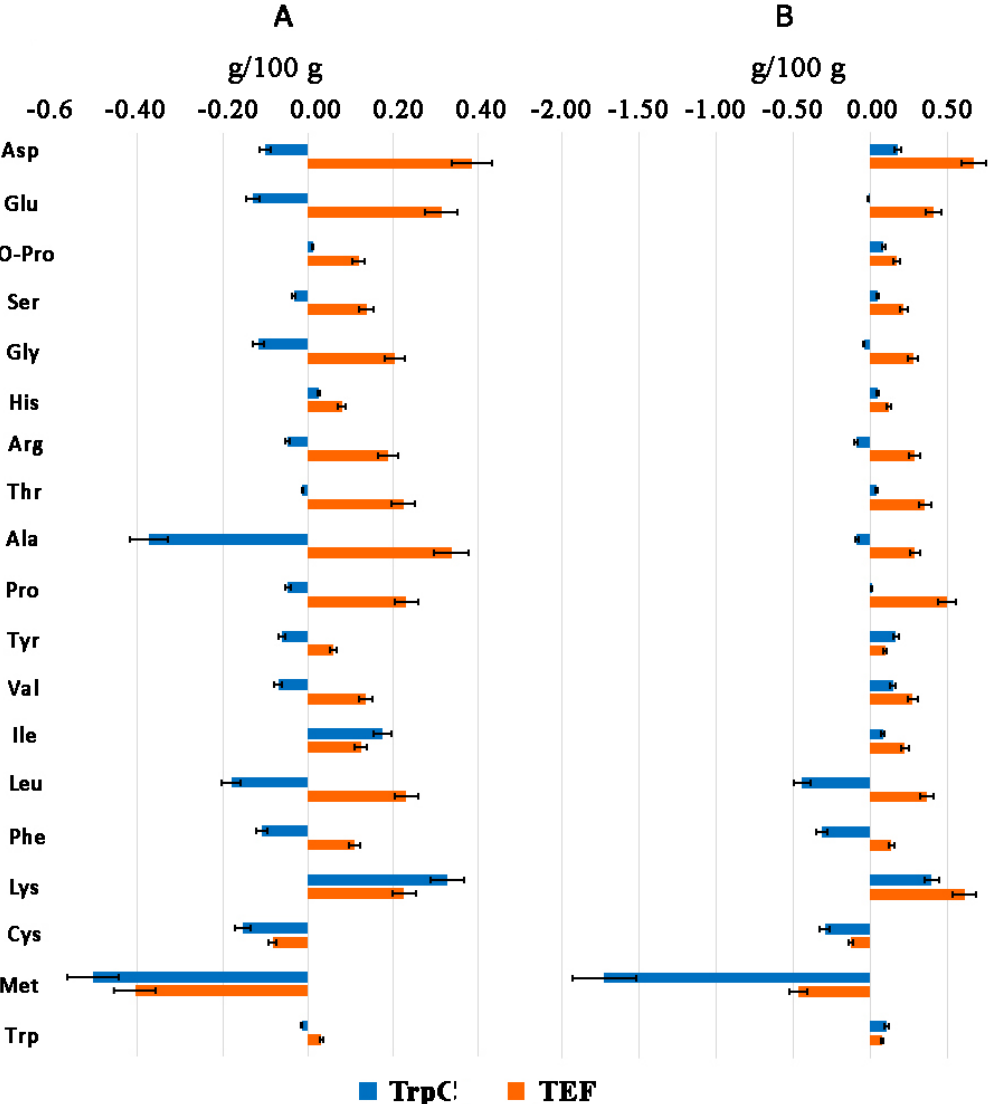
Figure 5. The differences in AA content in Th. thermophilus rF-859 clones TrpC (blue) and TEF (orange) relatively to the wild type strain after 14 ( A ) and 28 ( B ) days of cultivation (liquid potato-dextran medium, 45, without shaking).